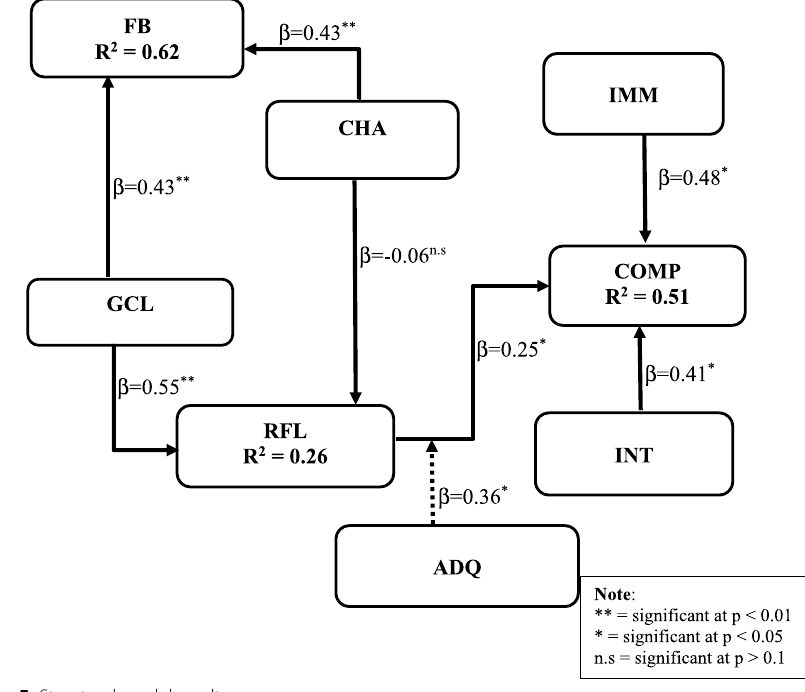
Fig. 5 Structural model